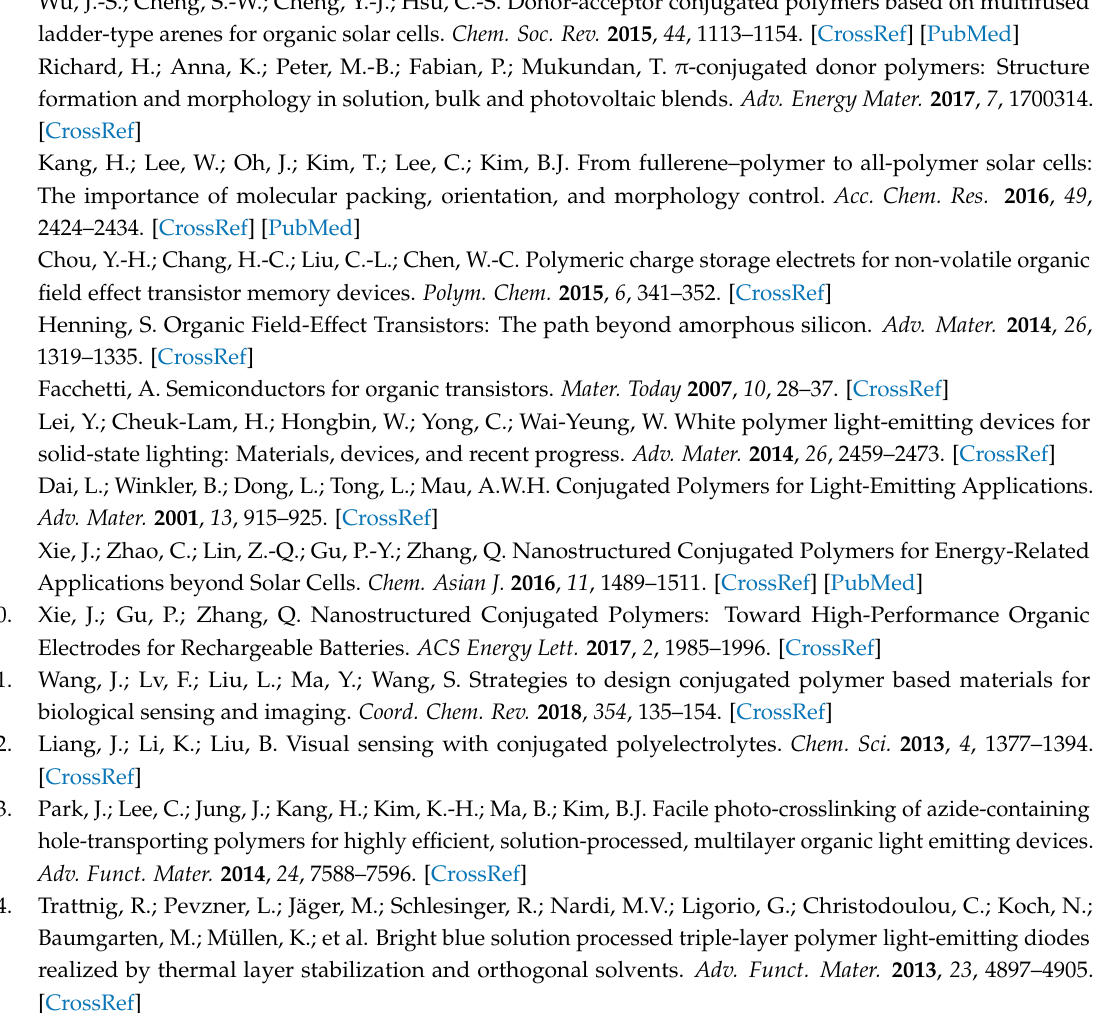
Figure S1: ATR-FT-IR spectrum of 2 , Figure S2: 1 H-NMR spectrum of 2 in CDCl 3 , Figure S3: 13 C{ 1 H} NMR spectrum of 2 in CDCl 3 , Figure S4: ATR-FT-IR spectrum of 3 , Figure S5: 1 H-NMR spectrum of 3 in CDCl 3 , Figure S6: 13 C{ 1 H} NMR spectrum of 3 in CDCl 3 , Figure S7: 1 H-NMR spectrum of 4 in CDCl 3 , Figure S8: 13 C{ 1 H} NMR spectrum of 4 in CDCl 3 , Figure S9: 29 Si{ 1 H} NMR spectrum of 4 in CDCl 3 , Figure S10: IR spectra of hybrid materials M4 25 (bottom) and M4 110 (top), Figure S11: Color evolution during the chemical polymerization of thiophene units in M4 110 . Figure S12: 13 C-CPMAS solid-state NMR spectra of M4 110 and P4 . Figure S13: TGA curve of lamellar polythiophene-silica hybrid material P4